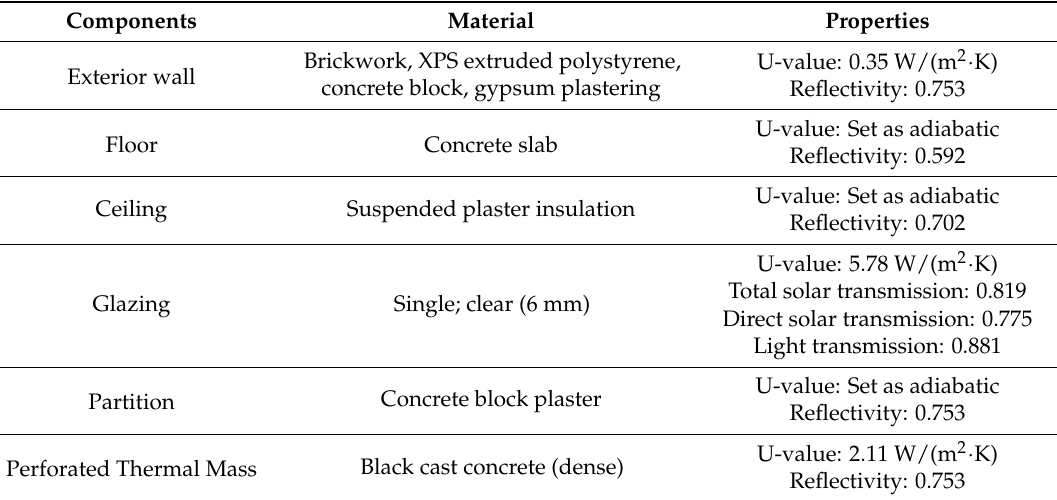
Figure 2. Simulation models: ( a ) the reference model (50% WWR); ( b ) an example test case. Table 2. Main parameter inputs of the simulation model.